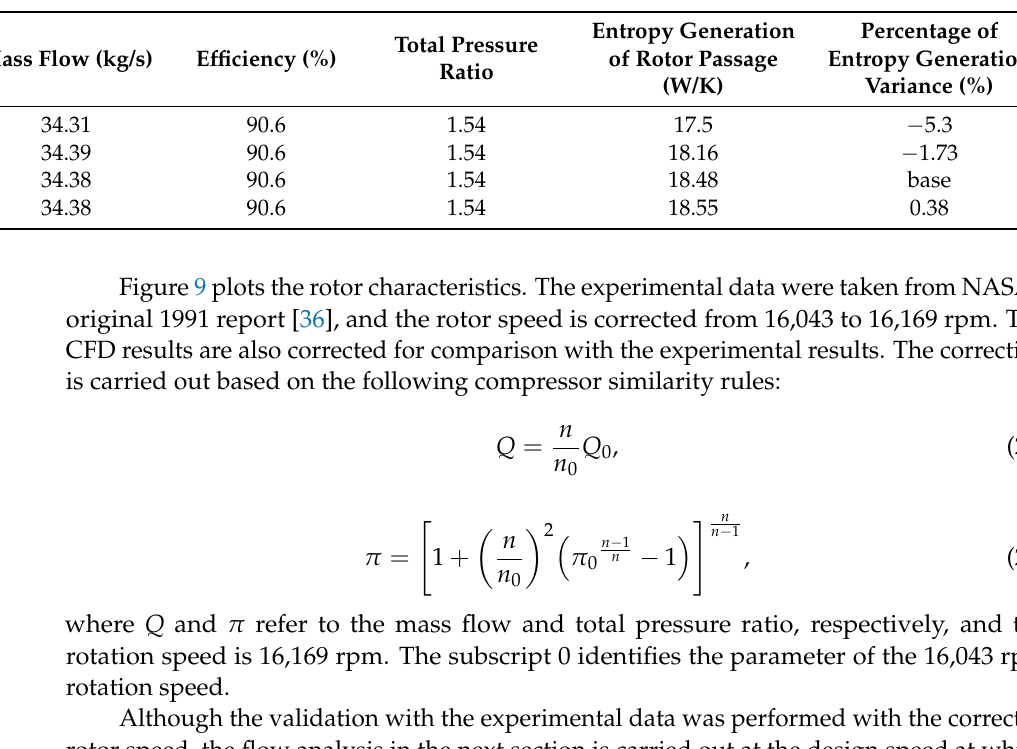
Figure 8. Curve showing grid independence in terms of overall EGR and the selected grid. Table 1. Compressor characteristics for different mesh